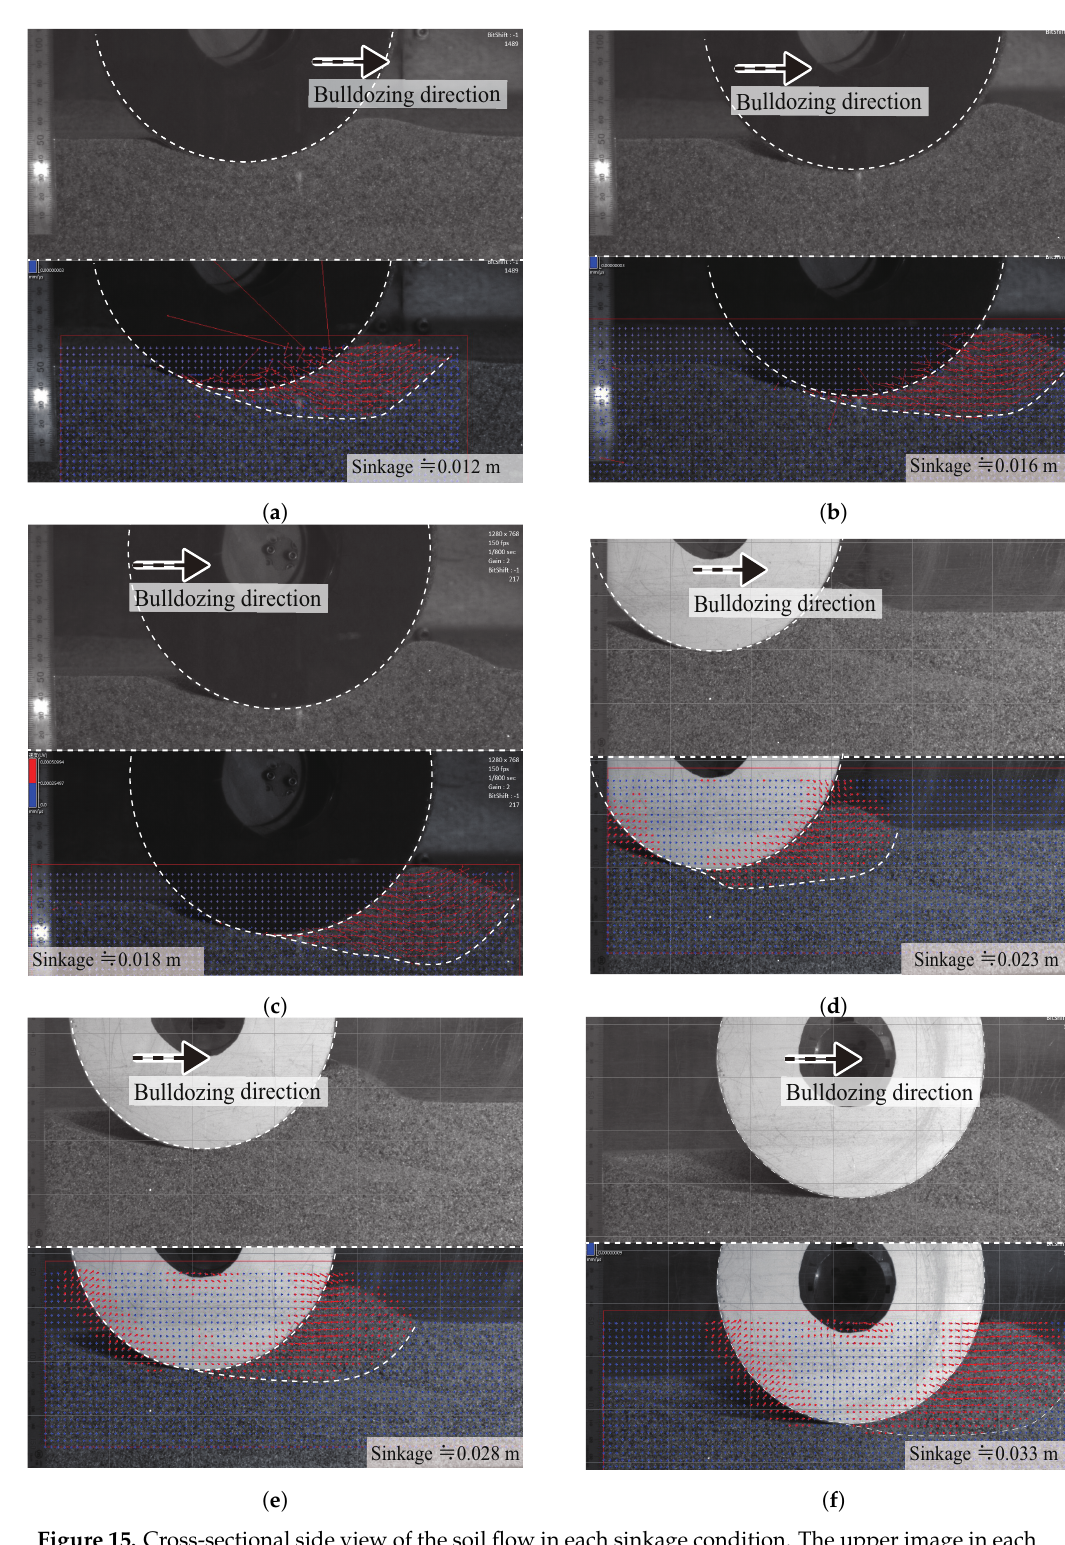
Figure 15. Cross-sectional side view of the soil flow in each sinkage condition. The upper image in each case is the raw image. The bottom images are images after PIV analysis. ( a ) Approximately 0.012 m, ( b ) approximately 0.016 m, ( c ) approximately 0.018 m, ( d ) approximately 0.023 m, ( e ) approximately 0.028 m, ( f ) approximately 0.033